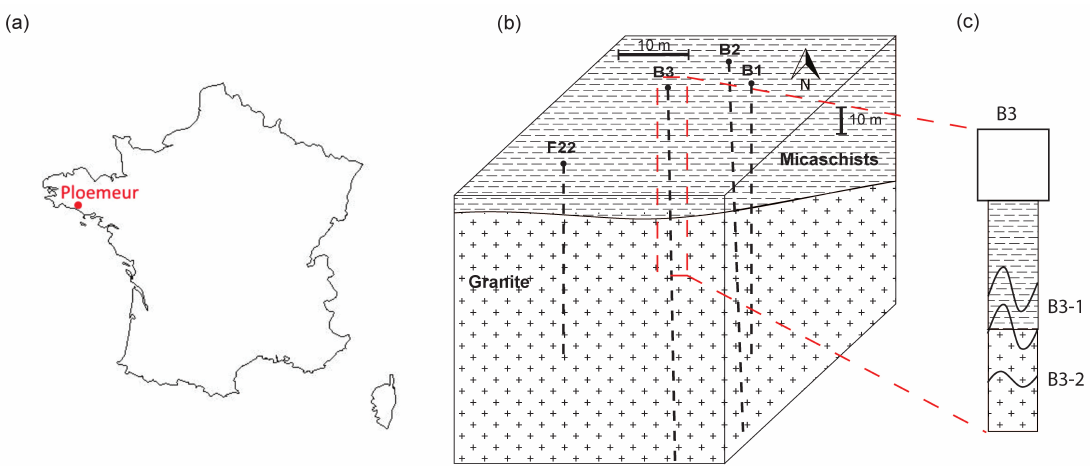
Figure 1. ( a ) Localization of the Ploemeur field site, ( b ) Geological diagram of Stang er Brune experimental site with the locations of the di ff erent boreholes and ( c ) geological log with main fracture localization derived from optical and acoustic logs.